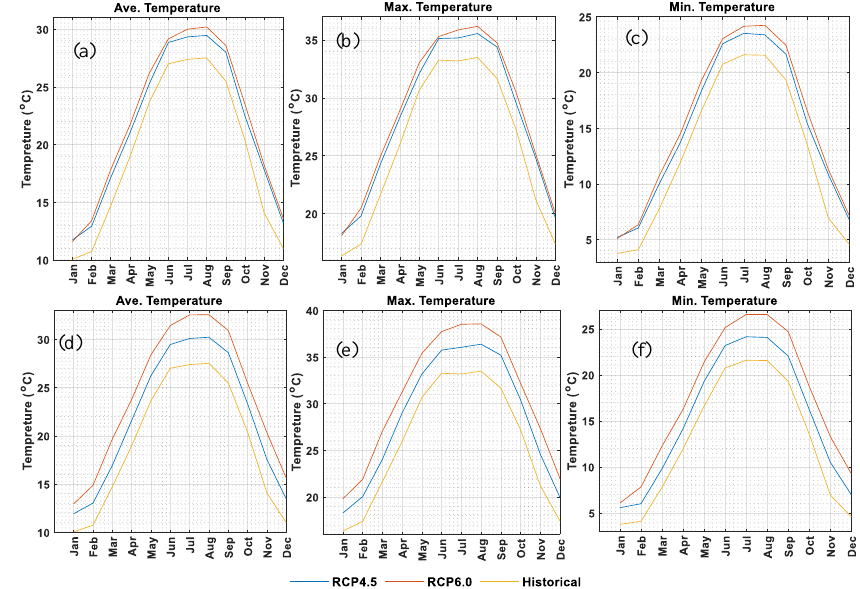
Figure 6. Monthly average of mean, maximum, and minimum temperatures based on the models and emissions scenarios; upper panel is for the mid-century and lower panel is for the late century (projected and historical). Subgraph ( a ) illustrates simulated and historical monthly average temperature under both scenarios during the mid-century. Subgraph ( b ) shows monthly maximum temperature under both scenarios during the mid-century. Subgraph ( c ) presents monthly minimum temperature under both scenarios during the mid-century. Subgraph ( d ) shows monthly average temperature under both scenarios during the late century. Subgraph ( e ) presents monthly maximum temperature under both scenarios during the late century. Subgraph ( f ) shows projected and historical monthly minimum temperature under both scenarios during the late century.